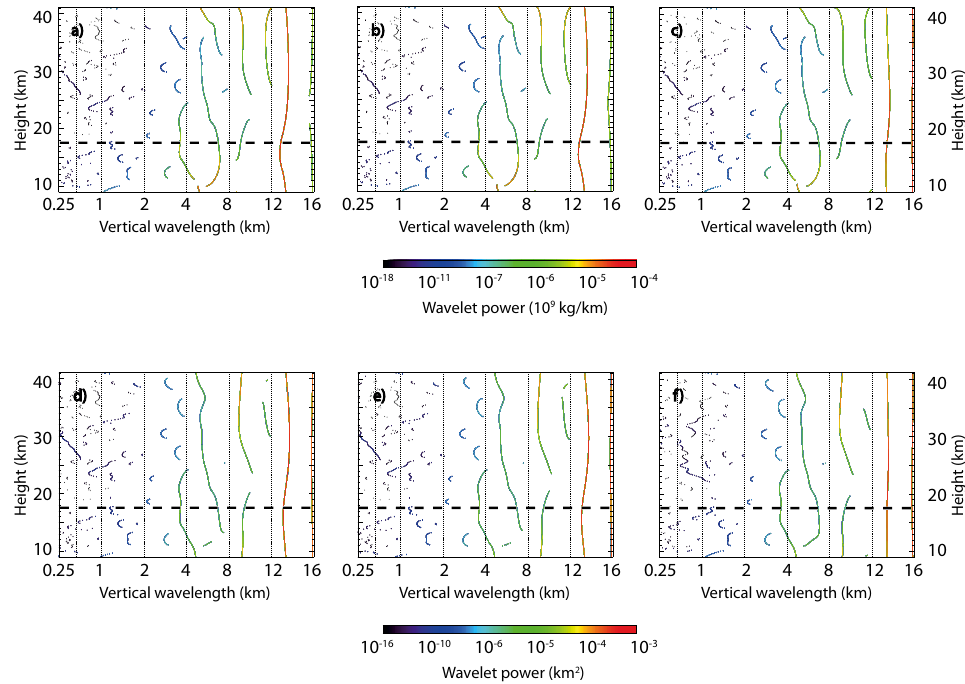
Figure 6. Wavelet power spectra skeletons of various perturbations resulting from different background states: scaled normalized density perturbations resulting from the sixth- (a) , fifth- (b) and (c) fourth-order polynomial fits; normalized density perturbations resulting from the sixth- (d) and (e) fifth-order polynomial fits; normalized dry temperature perturbations resulting from the (f) sixth-order polynomial fit.